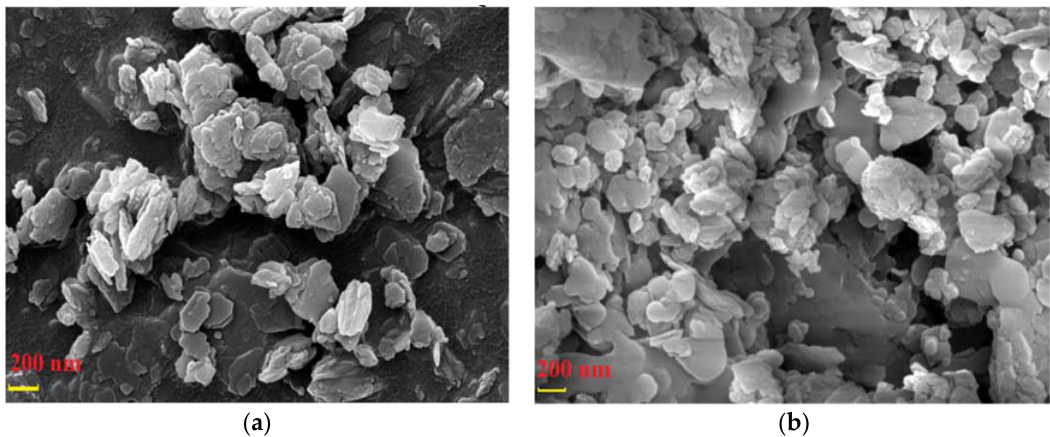
Figure 11. SEM photograph of ( a ) CSK and ( b ) calcined kaolin.